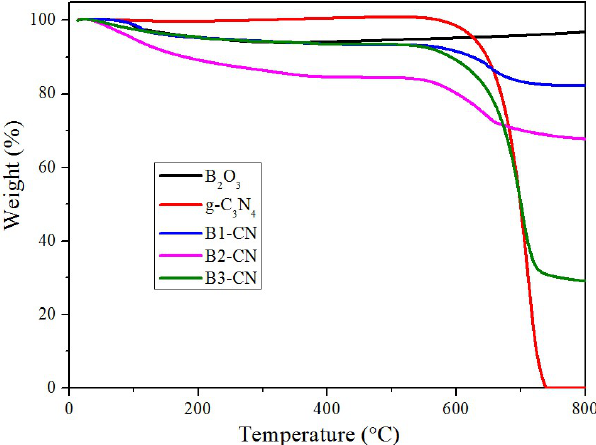
Figure 8. The thermo gravimetric curves of B 2 O 3 , CN, and CN/B 2 O 3 series materials.